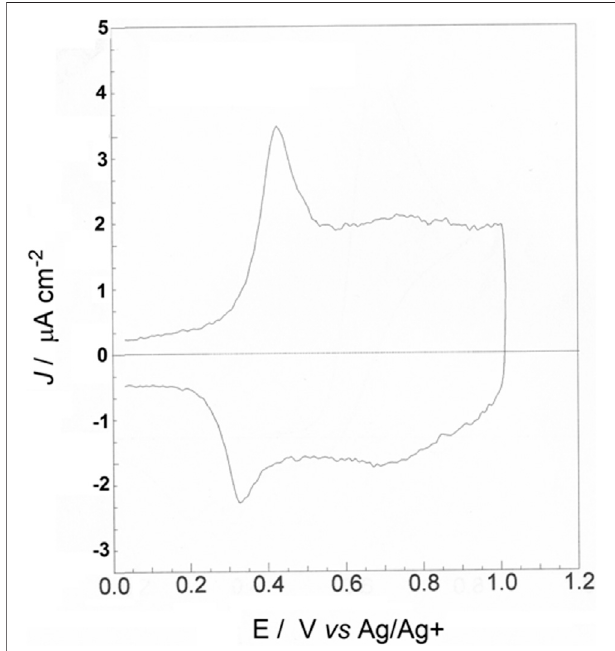
FIGURE 5 | Cyclic voltammetry of poly-3,3 ″ -DDTT deposited onto ITO (scan rate: 100 mV s − 1 ; electrolyte composition: 0.1 M TBAP in anhydrous ACN) when the electrodeposit displays a stabilized electrochemical behavior. The deposited charge of poly-3,3 ″ -DDTT was 25 mC. The amount of charge exchanged reversibly by poly-3,3 ″ -DDTT during oxidation was 4